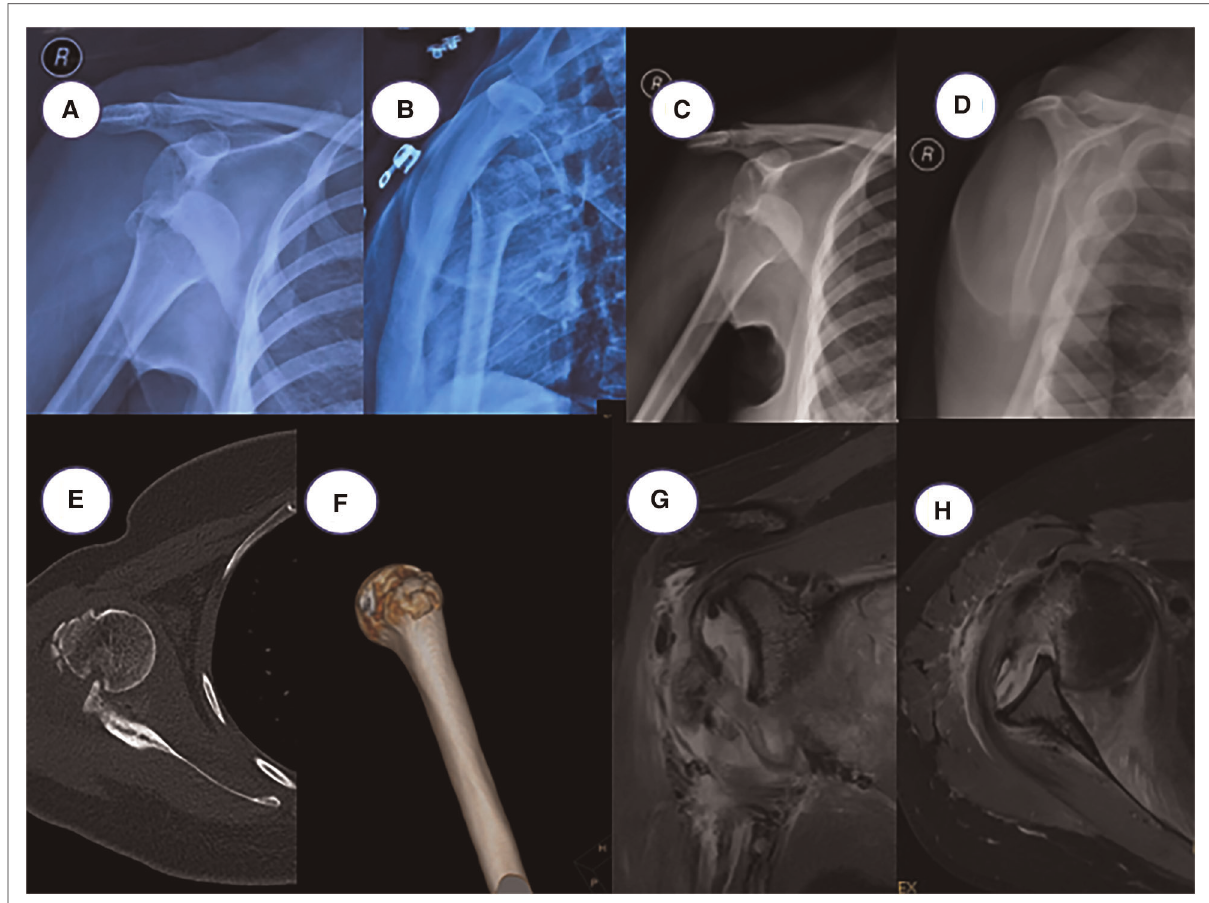
FIGURE 1 ( A,B ) postoperative x-ray after external emergency repositioning, ( C,D ) preoperative x-ray, ( E,F ) preoperative CT fi lm, ( G,H ) preoperative